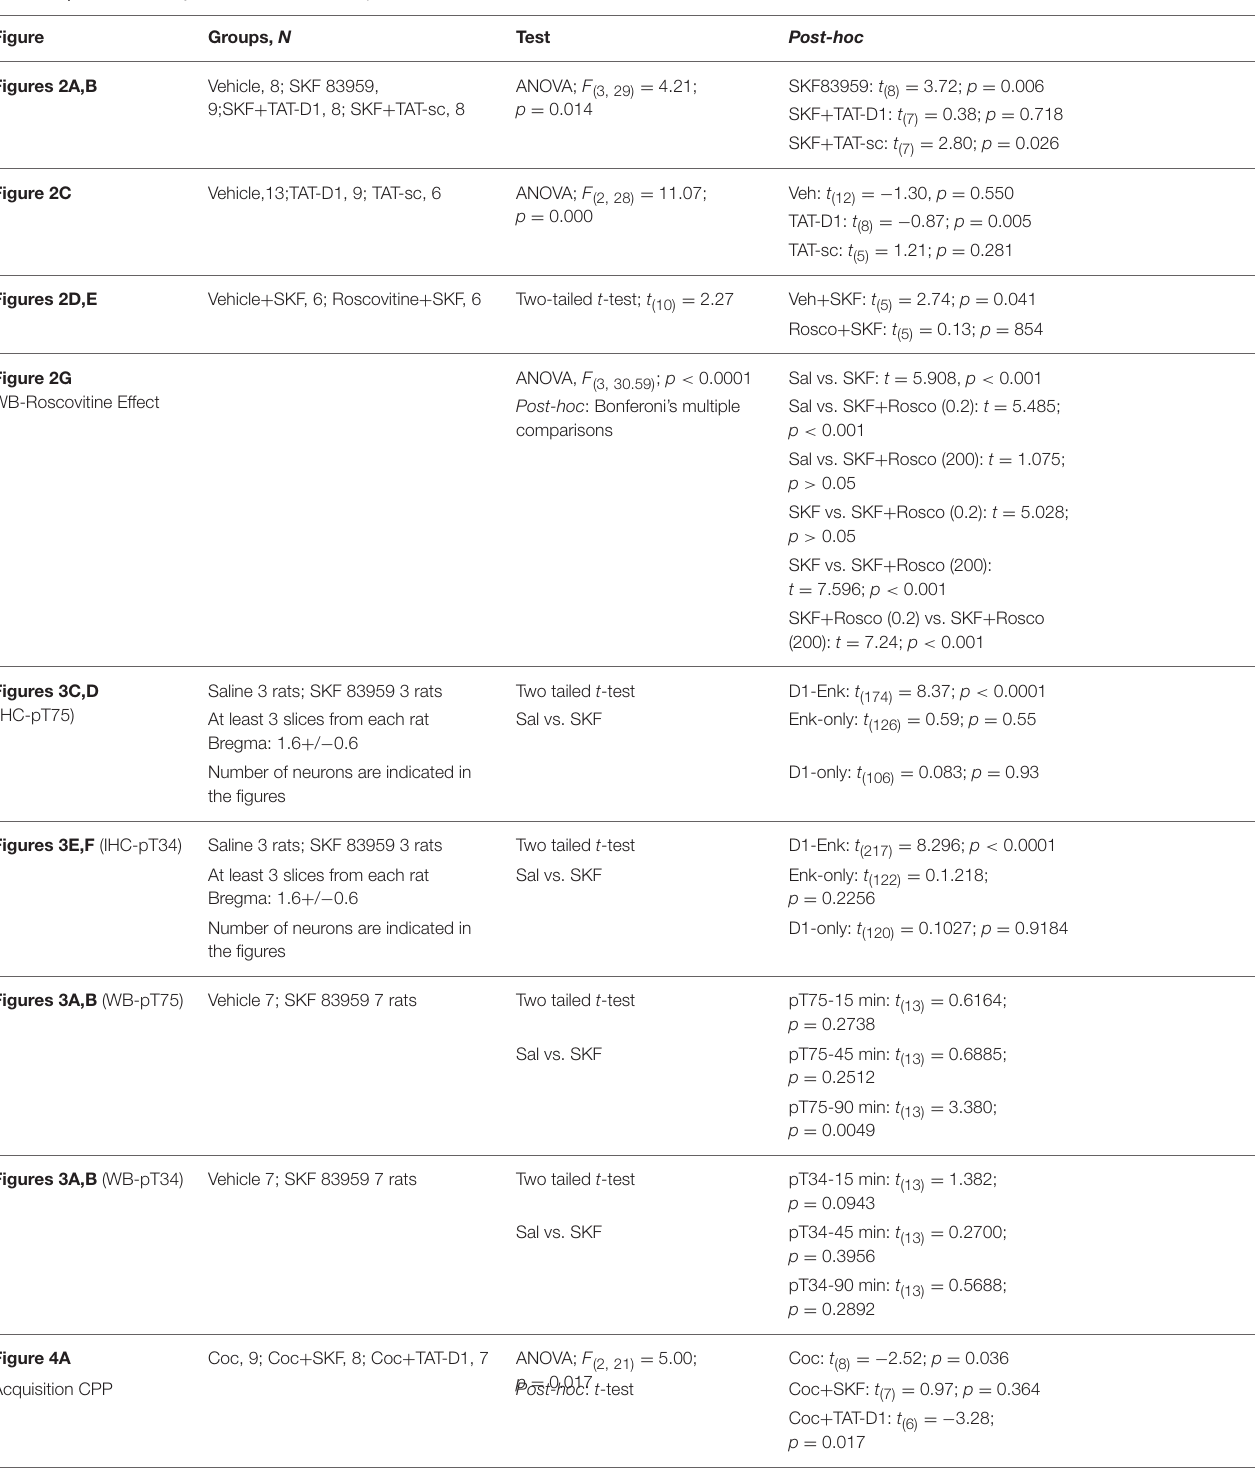
TABLE 1 | Statistical analyses for the individual experiments. Figure Groups, N